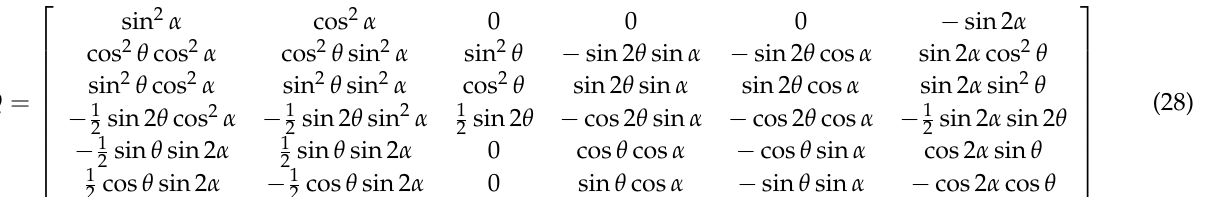
Figure 12. Transversely isotropic constitutive model with isotropic plane inclines. When the isotropic plane is tilted, the elastic matrix of the isotropic foundation in the axial coordinate system is: where [A] is the elastic matrix in the positive axis coordinate system, and [Q] is the transformation matrix of elastic parameters